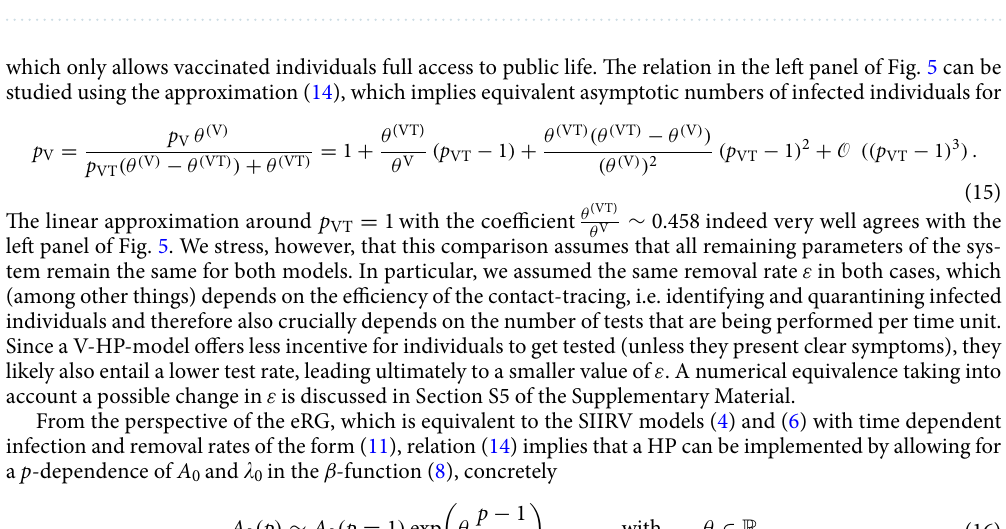
Figure 6. Time dependent parameters σ 1 (left panel) and ε (right panel) for the extremal cases of wave 4. The blue and orange colours are correlated with the curves in the right panel of Fig. F10 in the Supplementary